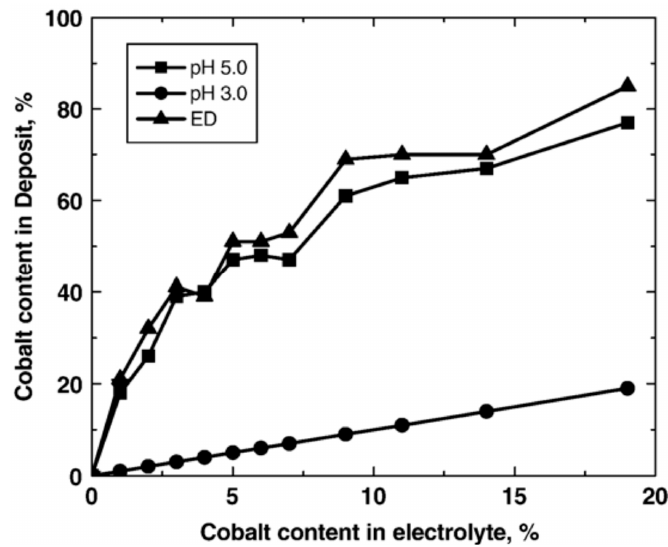
Figure 6. Alloy composition as a function of Co 2+ concentration in the electrolyte [16]. Reprinted from Surface and Coatings Technology, 201, Meenu Srivastava, V. Ezhil Selvi, V.K. William Grips, K.S. Rajam, Corrosion resistance and microstructure of electrodeposited nickel-cobalt alloy coatings / Pages No. 3051–3060, Copyright (2020), with permission from